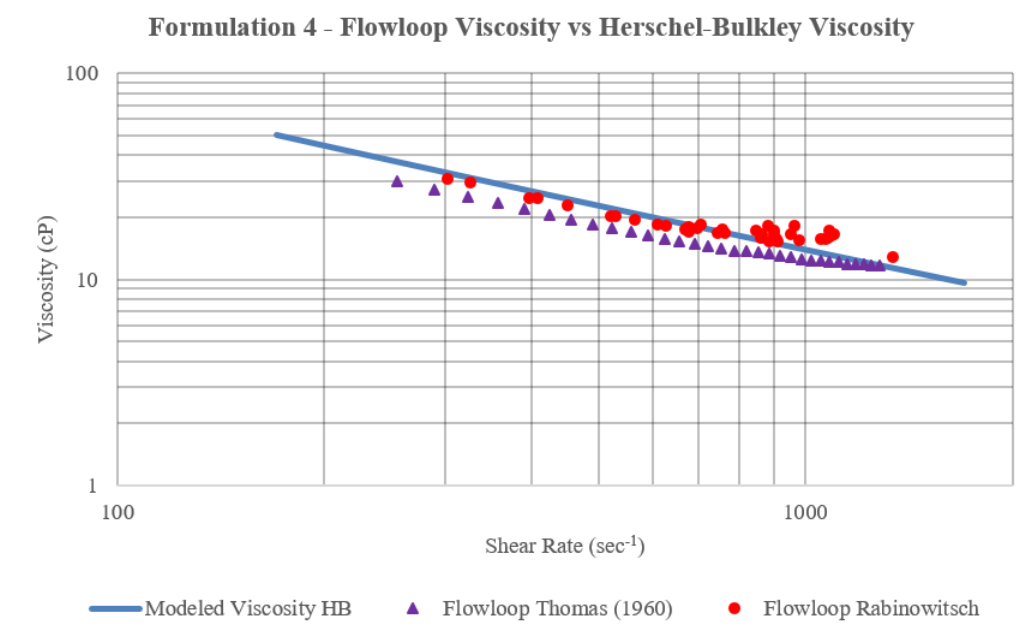
Figure 9: Estimated viscosity of Formulation 4